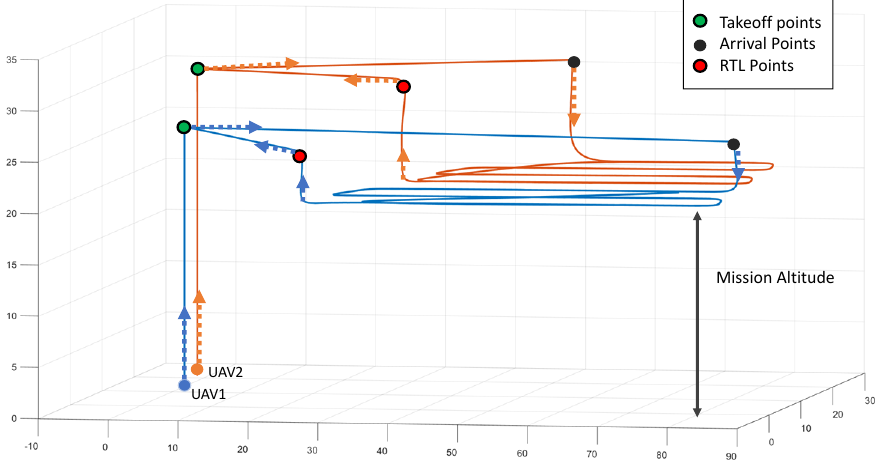
Figure 2. Mission operation schema. Each UAV takeoff at its assigned altitude, then performing the operation at mission altitude, and RTL at assigned altitude